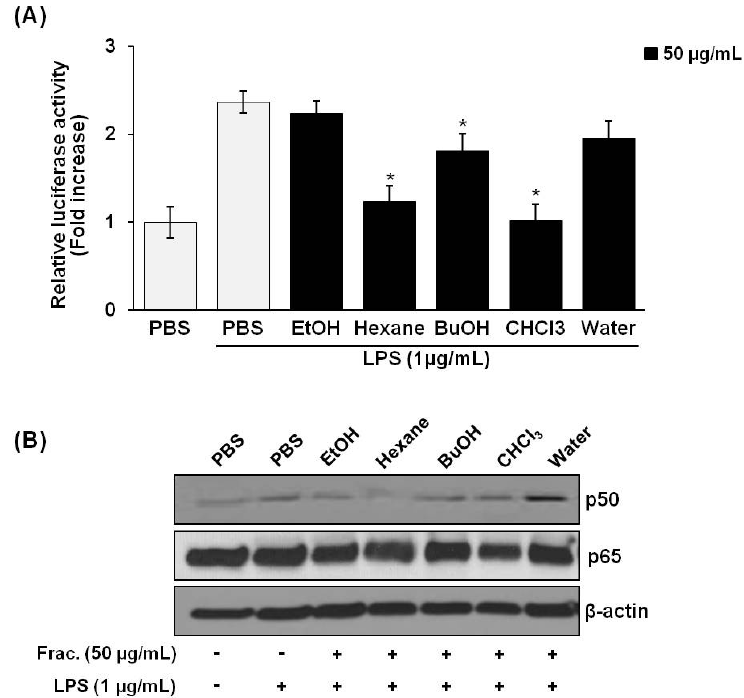
Figure 5. Effect of Prunella vulgaris var. lilacina on NF- κ B activation as measured by the luciferase assay ( A ), and on nuclear translocation of the p65 and p50 subunits ( B ) in LPS-stimulated RAW 264.7 cells. Cells were treated with fractions (50 μ g/mL) and stimulated with LPS (1 μ g/mL) for 12 h. * p < 0.05 significantly different from the LPS-stimulated PBS